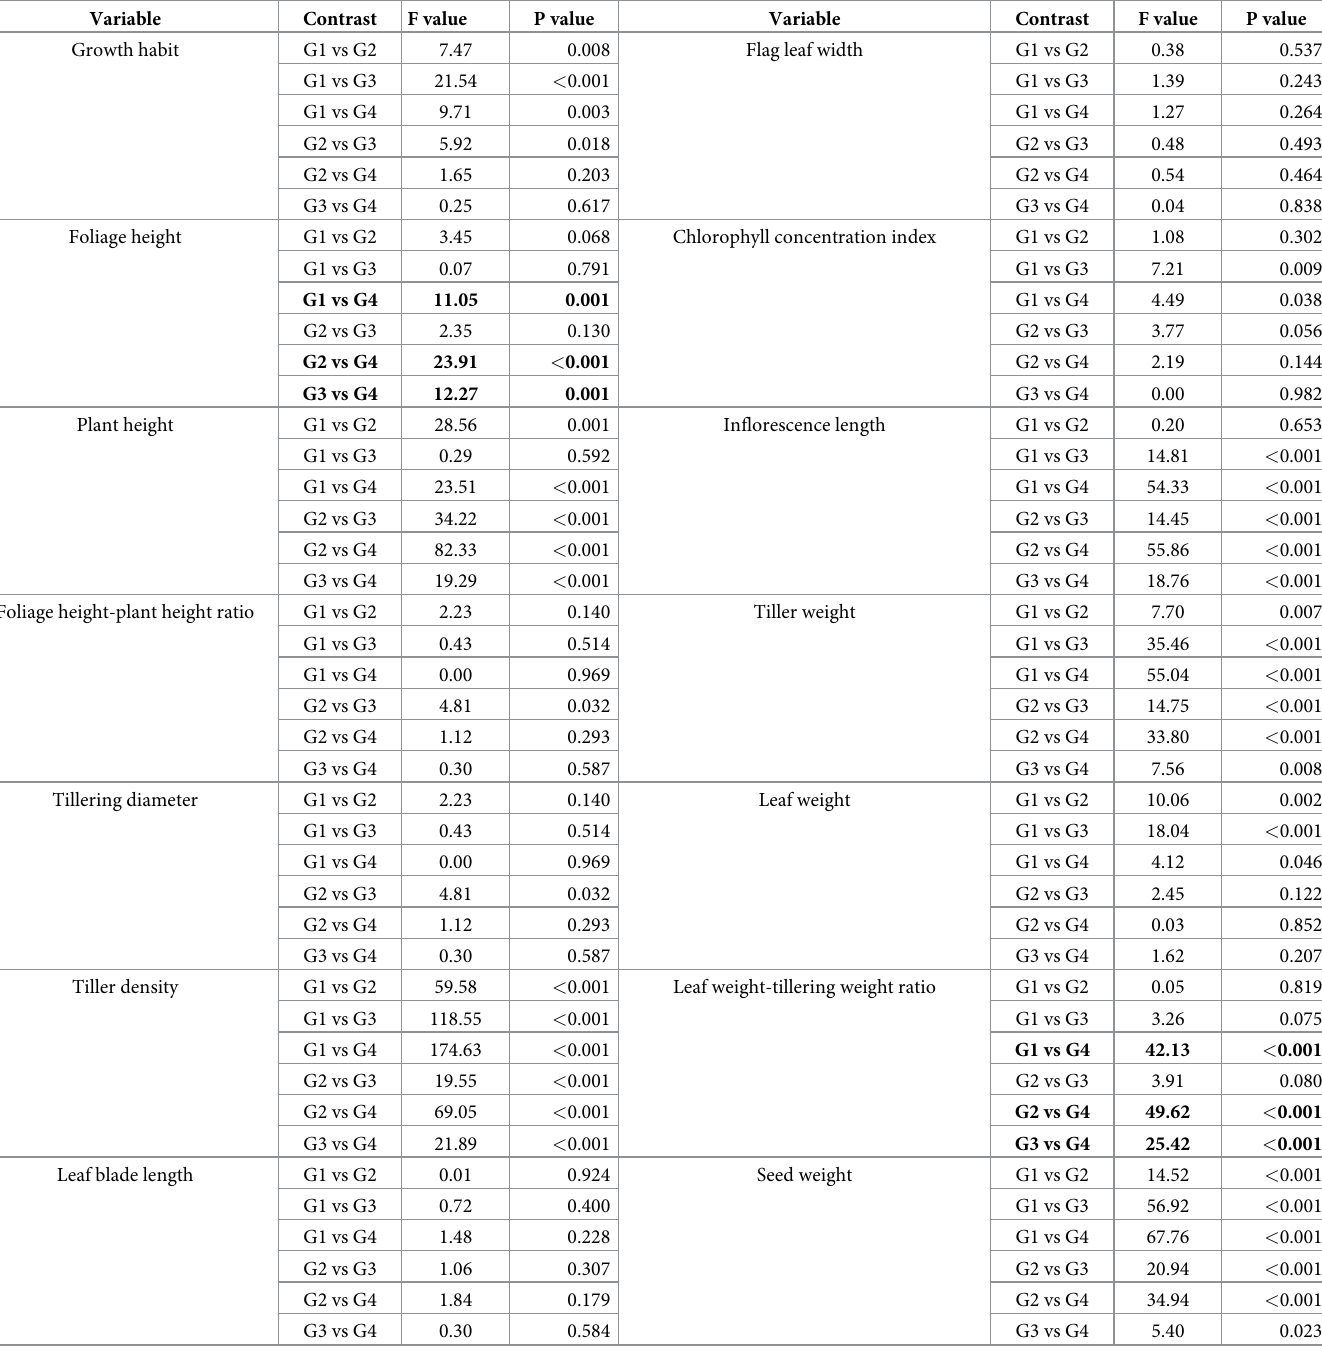
Table 1. Orthogonal contrasts per group formed in Hierarchical Clusters and for each morphological variable of genotypes of natal grass [ Melinis repens (Willd.) Zizka], developed from seed irradiated with Co 60 (M1) and from non-irradiated seed (M0).